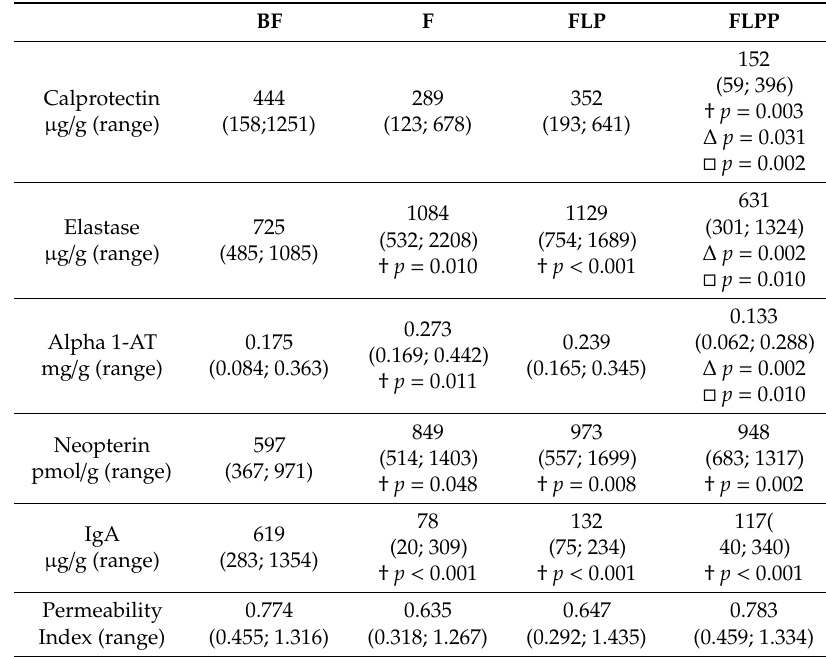
Table 3. Gut maturation parameters at week